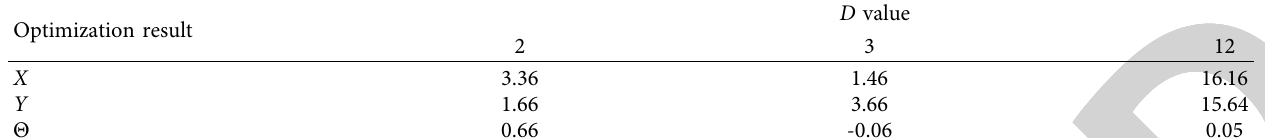
Table 12: The registration results of the rotated image e at different D values.